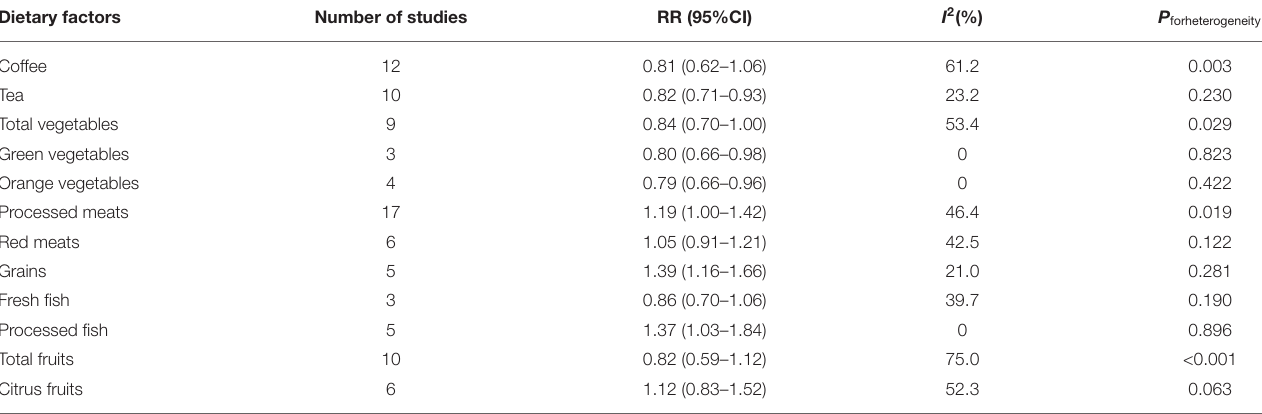
TABLE 2 | A meta-analysis for the association between dietary factors and glioma. Dietary